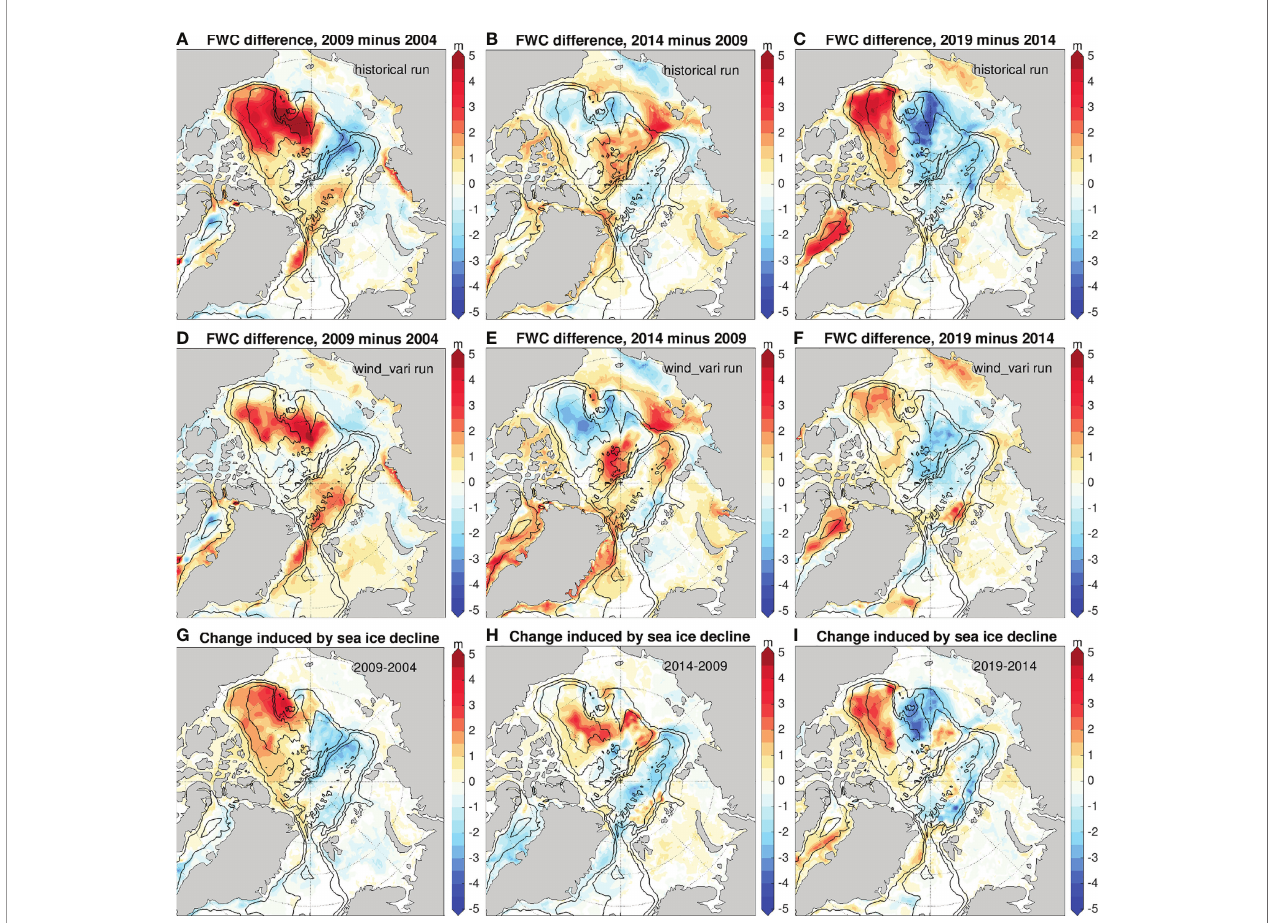
FIGURE 10 | Separated impacts of winds and sea ice decline on freshwater content (FWC, m) on pentadal time scales. (A – C) Changes of FWC in the historical simulation: (A) between 2004 and 2009, (B) between 2009 and 2014, and (C) between 2014 and 2019. (D – F) The same as (A – C) , but for the wind_vari simulation. (G – I) The changes due to sea ice decline in the corresponding period, which are calculated as the difference between the historical simulation ( fi rst row) and wind_vari simulation (second